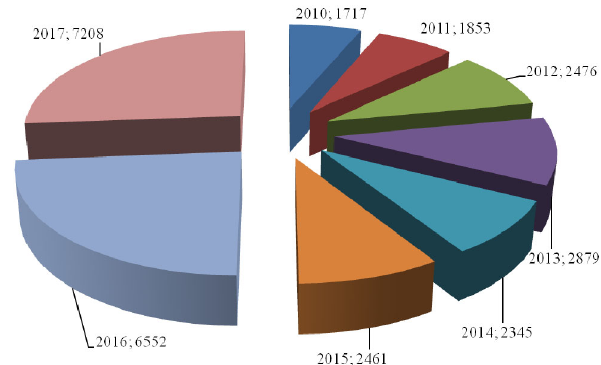
Fig. 5. Catching the aquatic bioresources in the inland water bodies of the Kherson region.